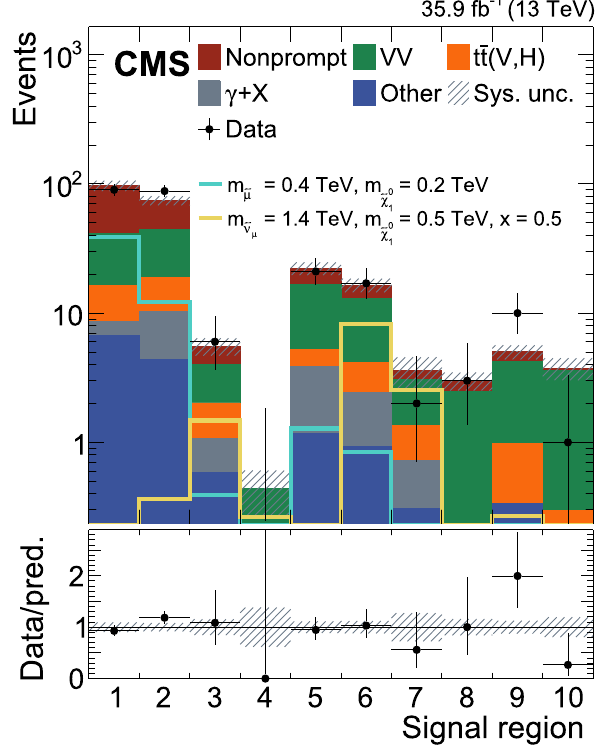
Fig. 2 Expected (after fit) and observed event yields in the SR bins as defined in Table 2. The gray band shows the systematic uncertainty in the background yields. Also shown are the expected yields for two signalpointsnormalizedtotheirexpectedlimitonthecrosssection.The vertical bars denote the Poisson confidence intervals calculated with the Garwood procedure, while the horizontal bars show the bin